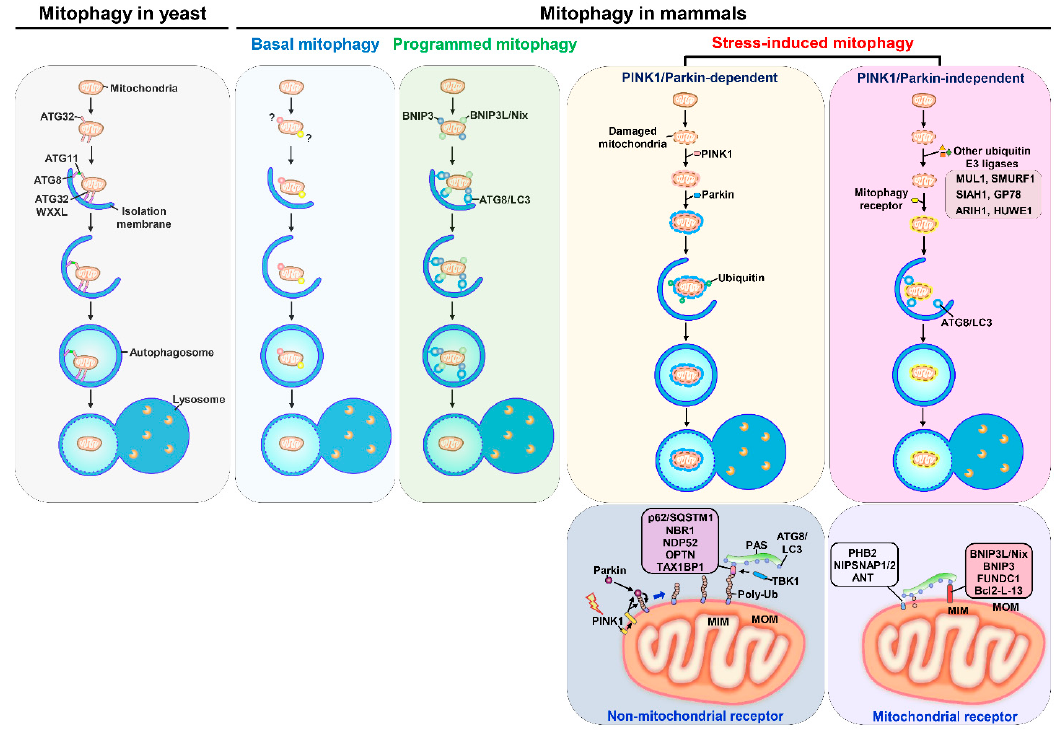
Figure 3. Di ff erent types of mitophagy in yeast and mammals. In yeast cells, the mitochondrial outer membrane-associated protein ATG32 represents a receptor involved in mitophagy that interacts with ATG8 located on IM / phagophore through the WXXL-like motif. Another adaptor protein, ATG11, may mediate the interaction between ATG32 and ATG8 to facilitate mitophagy initiation. At least three types of mitophagy have been in mammals, including basal mitophagy, programmed mitophagy, and stress-induced mitophagy. Basal mitophagy has been shown to be activated in the tissues with large metabolic demands, but the specific receptor for basal mitophagy remains unclear. The cargo receptors of programmed mitophagy, including BNIP3 and BNIP3L / Nix, function in mitochondrial turnover for the maturation of erythrocytes and cardiomyocytes, and elimination of the parental mitochondrial genome during fertilization. Stress-induced mitophagy is classified into PINK1 / Parkin-dependent mitophagy and PINK1 / Parkin-independent mitophagy. For the activation of PINK1 / Parkin-dependent mitophagy, mitochondrial depolarization triggers the suppression PINK1 degradation and leads to PINK1 accumulation on the MOM of damaged mitochondria. In turn, PINK1 phosphorylates ubiquitin and Parkin at serine residue 65 and then promotes the mitochondrial translocation of Parkin and mitochondrial ubiquitination by Parkin. On the other hand, several ubiquitin E3 ligases, including MUL1, SMURF1, SIAH1, GP78, ARIH1, and HUWE1, may promote the ubiquitination of mitochondrial proteins to activate PINK1 / Parkin-independent mitophagy. Several non-mitochondrial cargo receptors, including p62 / SQSTM1, Calcoco2 (also known as NDP52), OPTN, NBR1, and TAX1BP1, are responsible for PINK1 / Parkin-dependent mitophagy. The phosphorylation of cargo receptors by tank-binding kinase 1, such as OPTN and p62 / SQSTM1, facilitate the recognition process of mitophagy. Several MOM- and MIM-associated proteins, such as BNIP3, BNIP3L / Nix, FUNDC1, BCL2-L3, PHB2, ANT complex, and NIPSNAP1 and 2 have been identified as cargo receptors for mitophagy that directly bind to ATG8 / LC3 located on the IM / phagophore.